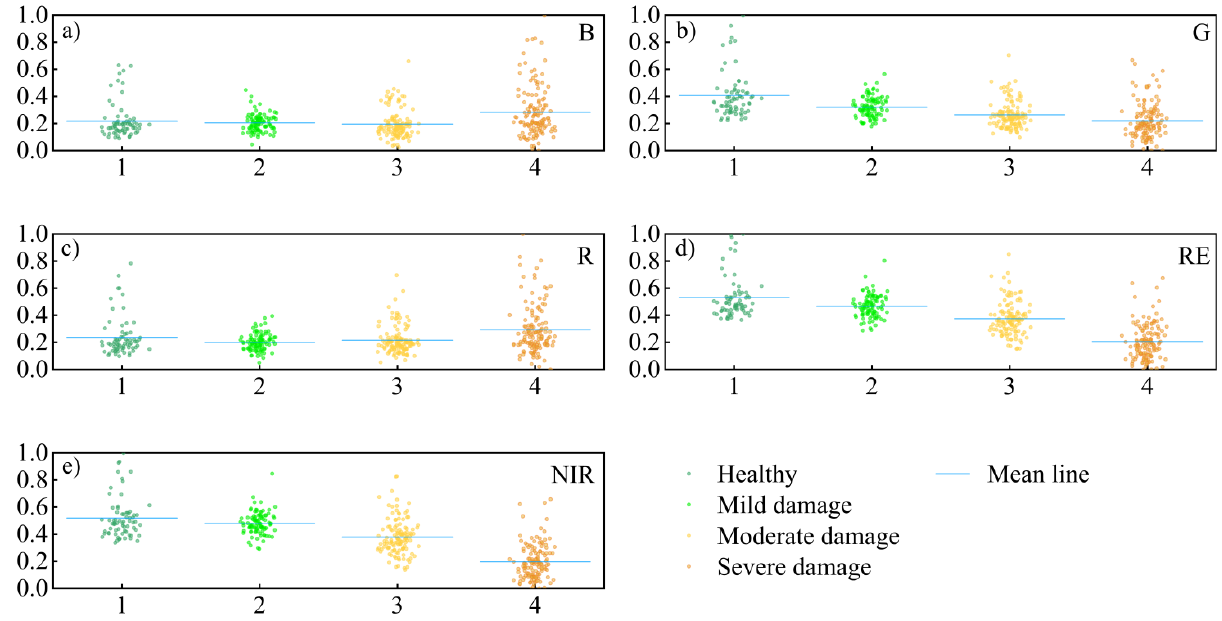
Figure 2. Variation characteristics of each index according to damage severity. ( a ) B, ( b ) G, ( c ) R, ( d ) RE and ( e )